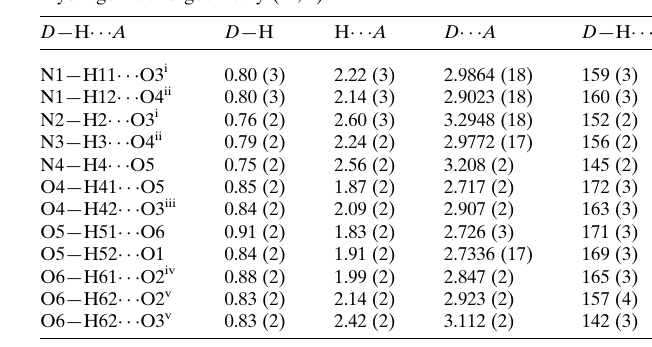
Table 1 Hydrogen-bond geometry (A˚ , (cid:4) ).